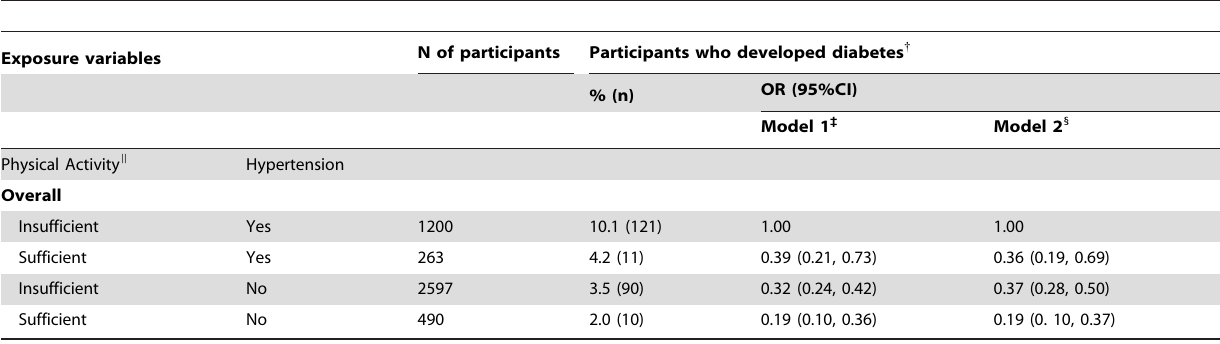
Table 3. The joint influence of physical activity and hypertension on the risk of developing diabetes at three-year follow-up among overall sample population in urban areas of Nanjing,